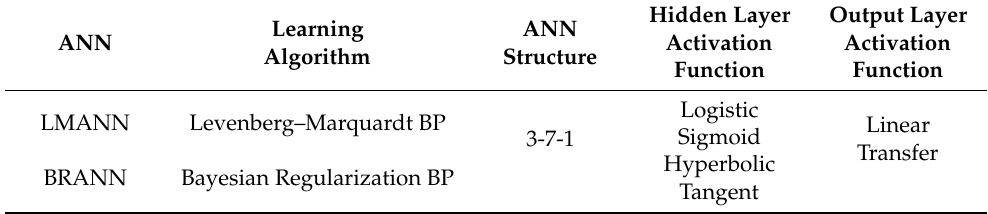
Table 5. Properties of the used